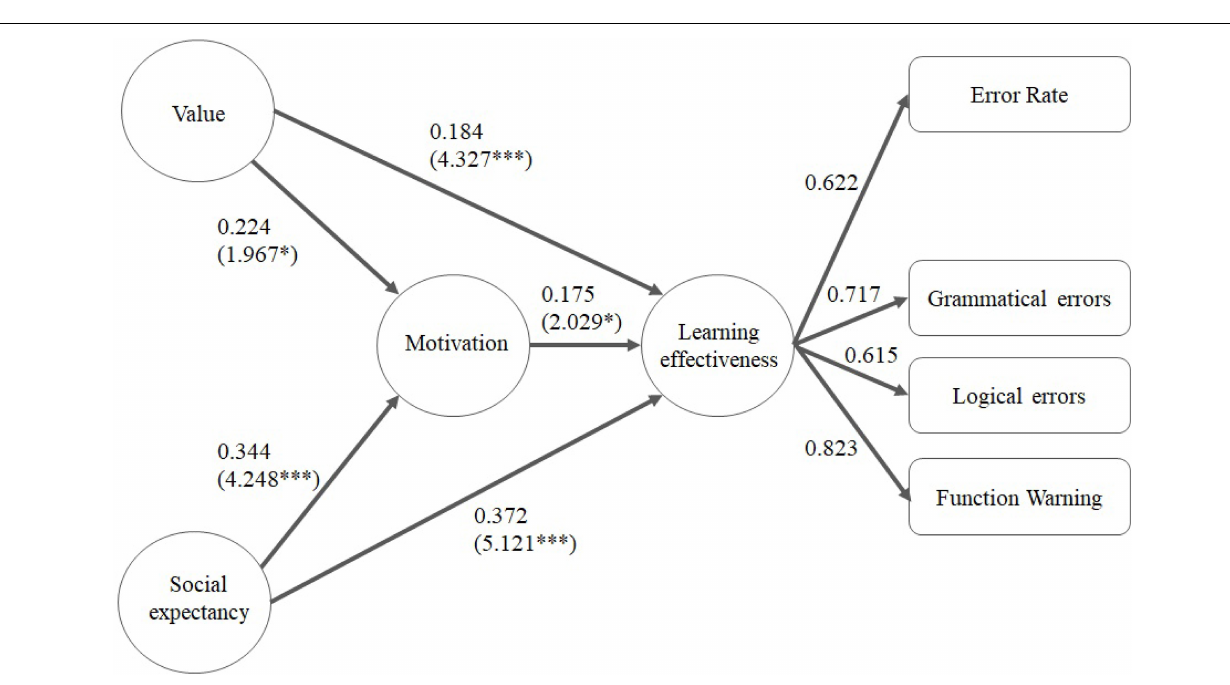
FIGURE 4 | Impact of students’ learning motivation on their learning